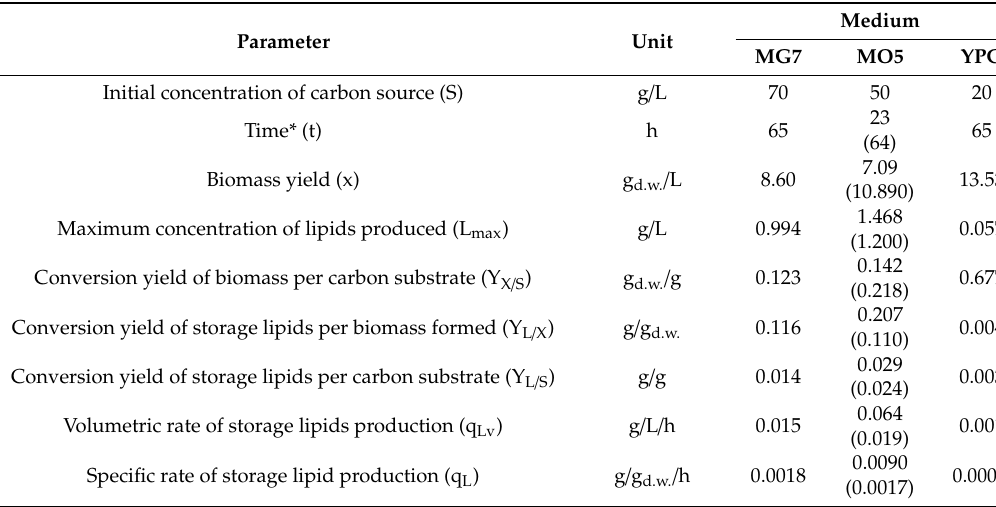
Table 1. Kinetic parameters of storage lipid biosynthesis in a batch bioreactor culture of Y. lipolytica in MG7, MO5, and control YPG medium (* for a better comparison of yeast cultures, the values of kinetic parameters in brackets refers to the end of culture in MO5 medium; values without brackets in column for MO5 medium refers to the time of culture in which the highest value of concentration of lipids produced was